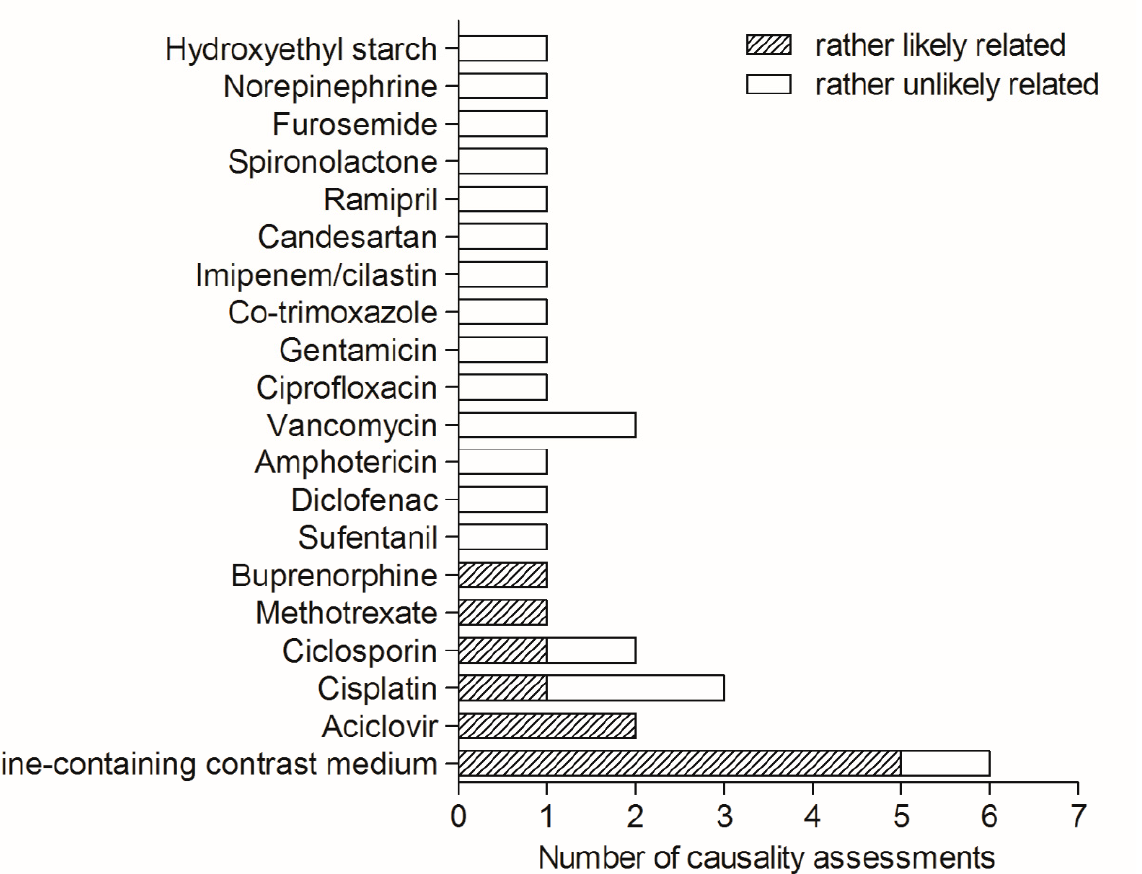
Figure 1. Causality assessment for adverse events and involved drugs: Outcome of the 30 causality assessments in 20 patients after consensus finding. Twenty different drugs were involved. A rather likely causal relationship to the adverse event was found for six different drugs, corresponding to eleven inpatient cases. Multiple causality assessments for the same patient occurred in four patients.